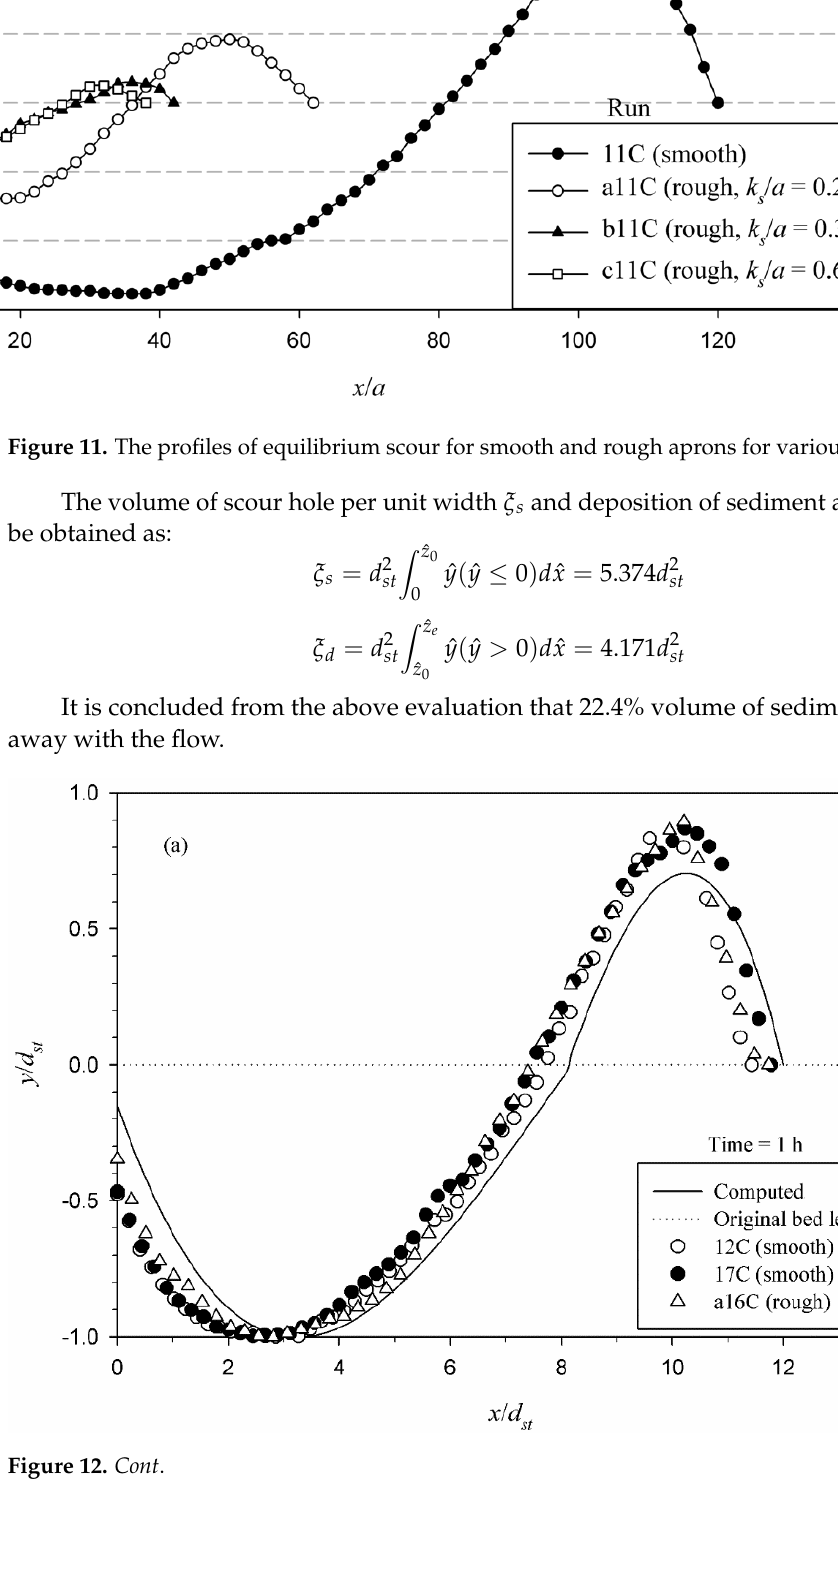
Figure 12. Non-dimensional scour profiles for different runs at ( a ) t = 1 h and ( b ) t = 8 h. The volume of scour hole per unit width ξ s and deposition of sediment as ridge ξ d can be obtained as: